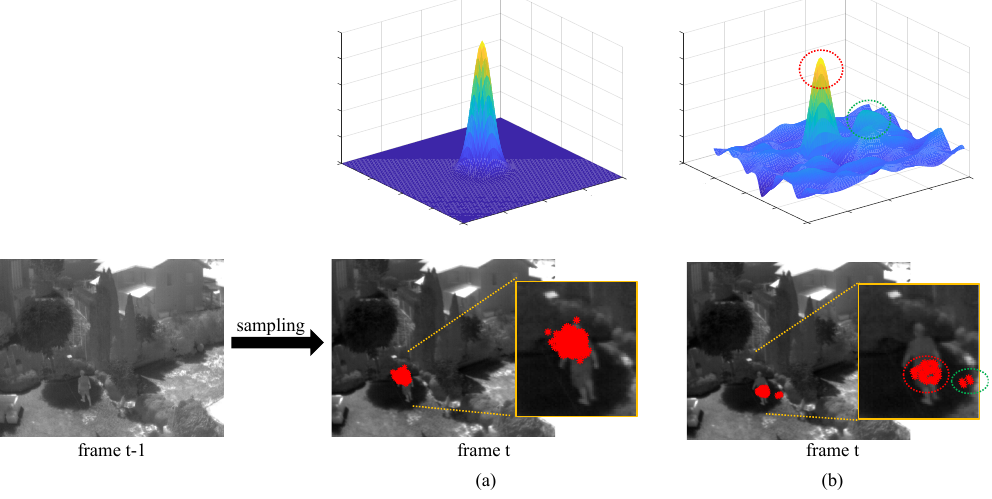
Figure 3. Visualization of particle distribution: ( a ) 300 particles are sampled, which are modeled by the Gaussian distribution; snf ( b ) 50 discriminative particles are drawn according to the peak values of the response map obtained from the correlation